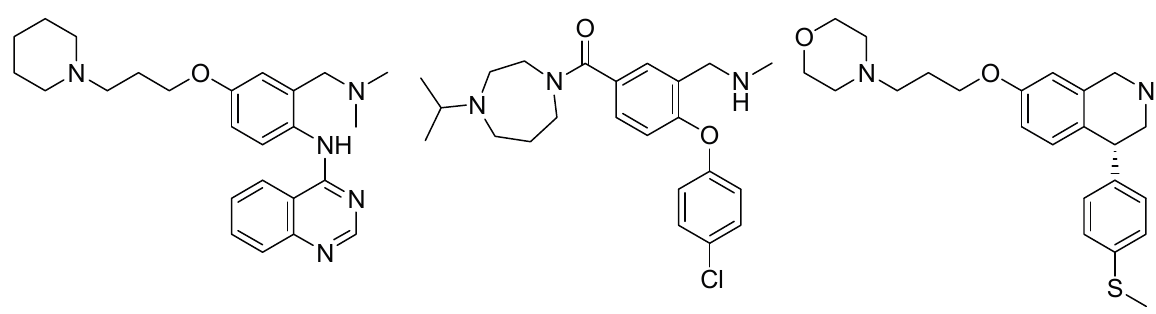
Figure 5. Dibasic H 3 receptor antagonists carrying a lipophilic